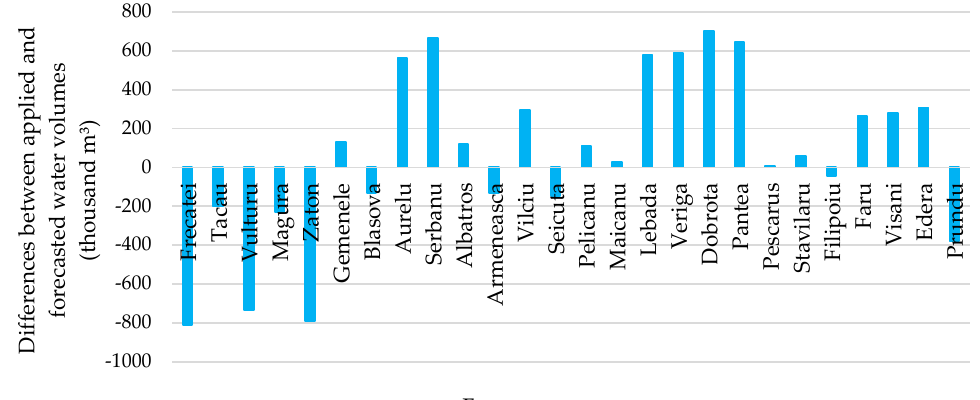
Figure 13. Differences between forecasted and applied irrigation in 2018, at the level of farms located in the IMB Irrigation District.